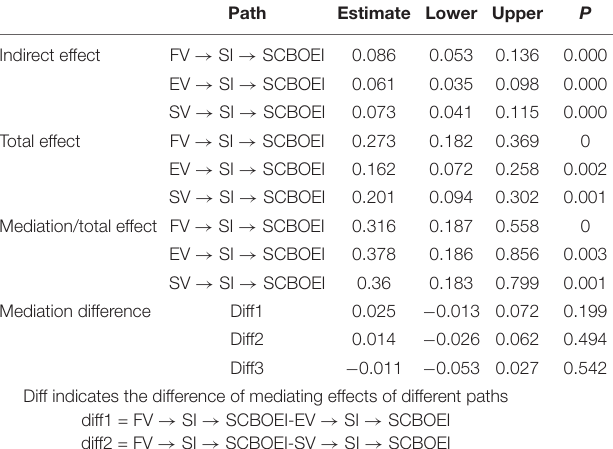
TABLE 9 | Results of mediation analysis using